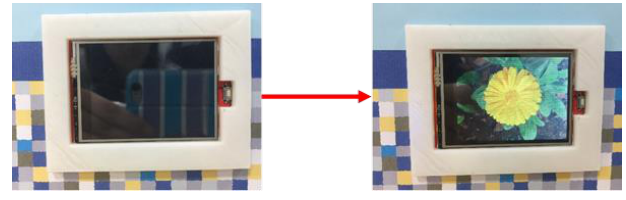
Figure 16. Turning on the TV via the swing upwards movement.